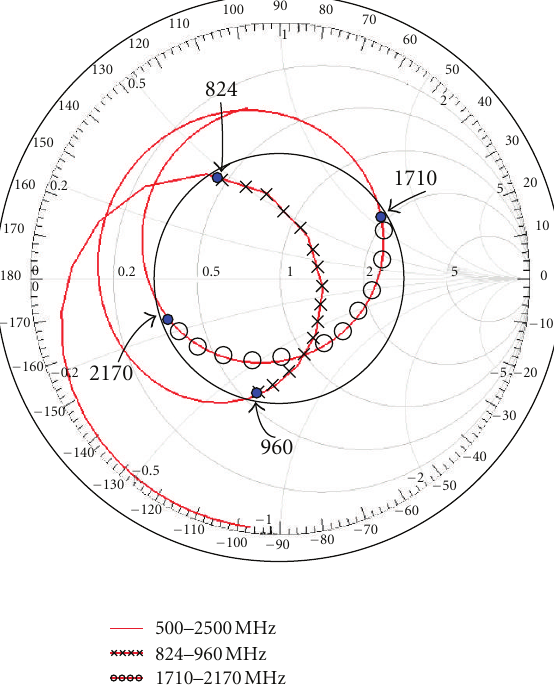
Figure 4: Simulated input impedance on the Smith